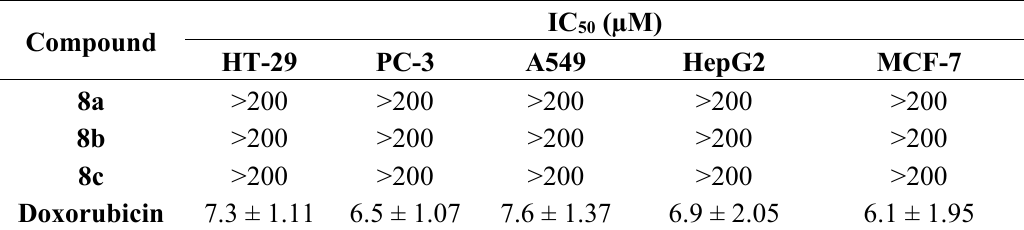
Table 2. Levels of cytotoxicity induced by hydrazides 8a – c on different cell lines.